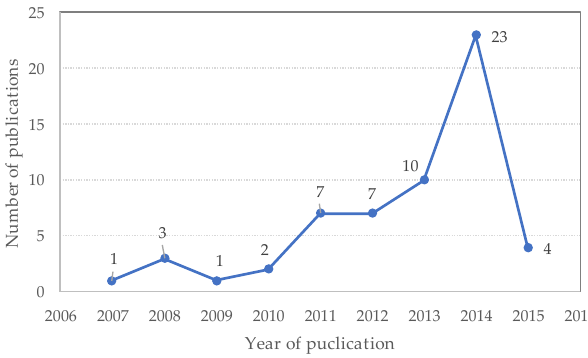
Figure 4. Number of studies meeting criteria for review, by year (studies published through December 2015).